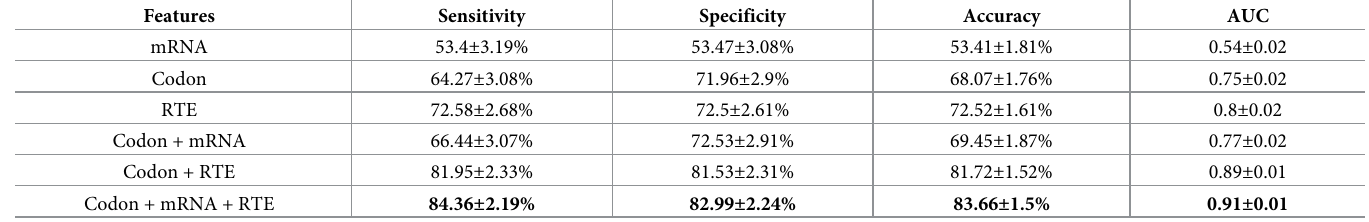
Table 2. Classification results of the random forest